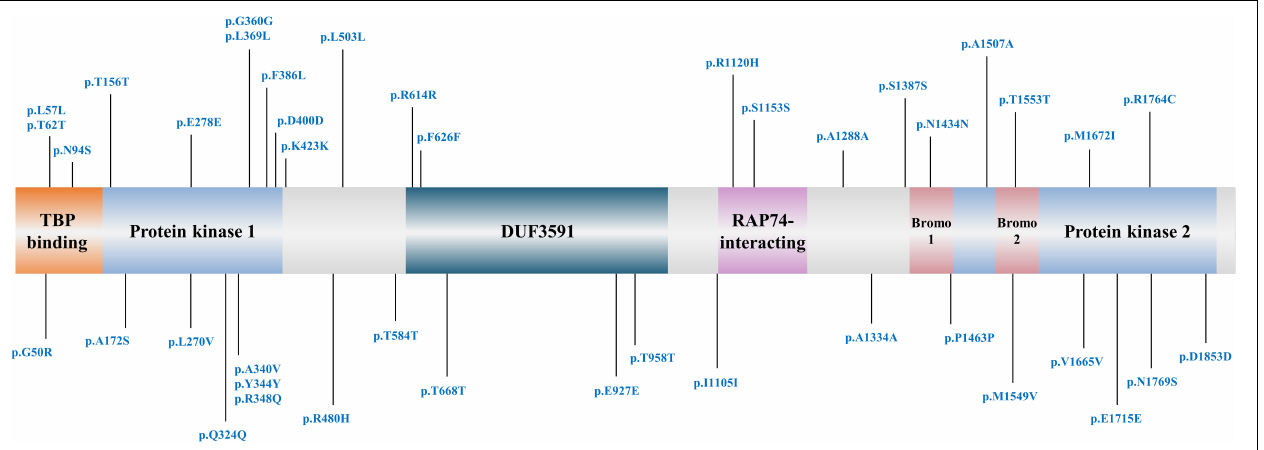
FIGURE 1 | Rare coding variant sites of TAF1 gene included in our study.